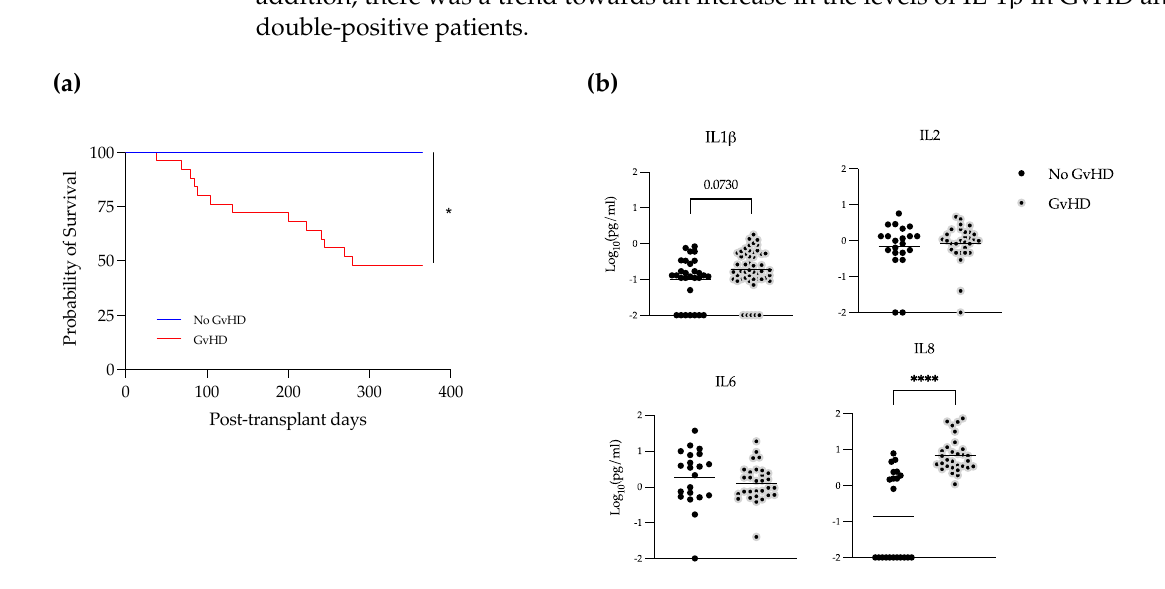
Figure 4. IL-1 β and IL-8 increase in EBV-positive samples during GvHD. ( a ) Survival curve of patients with or without GvHD. Kaplan–Meier method, * = p < 0.05. ( b ) Plasma levels of the indicated cytokines in samples EBV-positive with or without GvHD. Mann–Whitney test., **** = p < 0.0001.